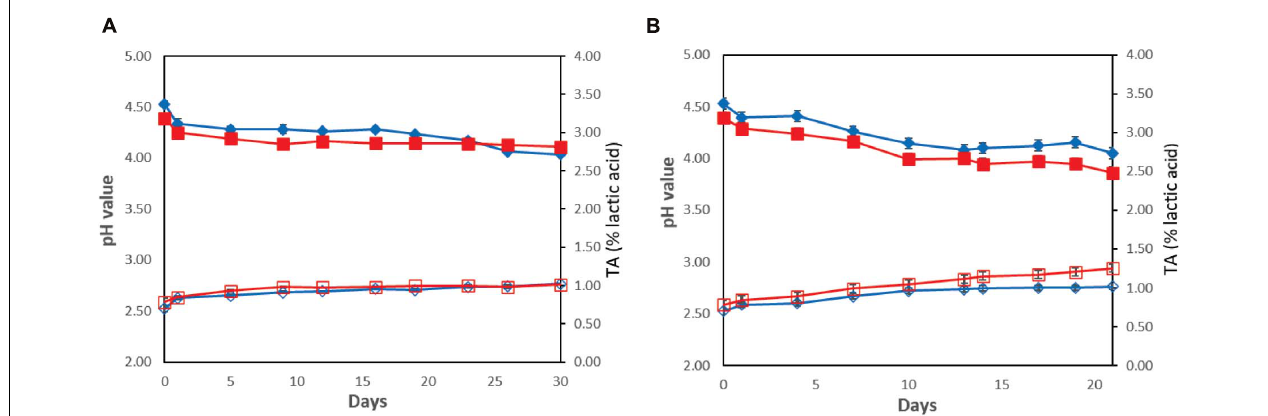
FIGURE 4 | Changes in yogurt samples during storage without ( (cid:7) ) or with ( (cid:4) ) addition of Lb. plantarum T571 in pH values (primary axis) and without ( ♦ ) or with ( (cid:3) ) addition of Lb. plantarum T571 in titratable acidity (secondary axis) (% lactic acid) at 4 ◦ C (A) and 12 ◦ C (B) .